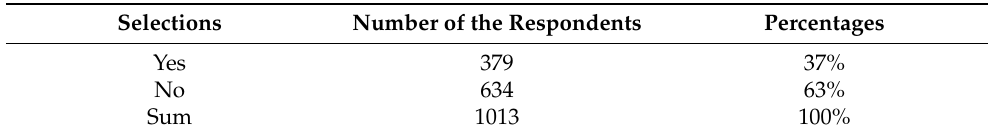
Table A18. Do you think that exchange platforms of cryptocurrencies existed on the Internet are legal in China (single-choice question)?